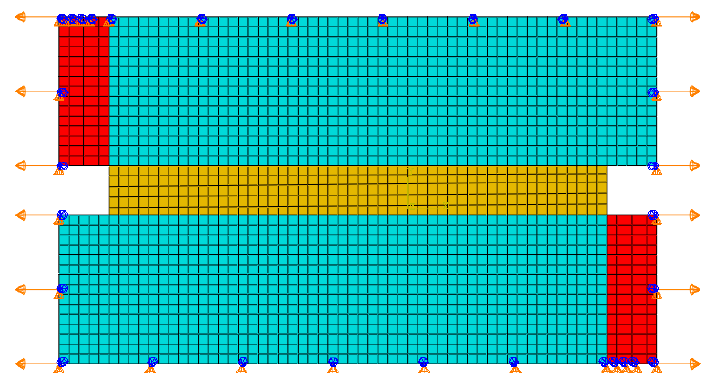
Figure 8. Finite element modelling (FEM) model with mesh properties of the unit cell. Cohesive elements are inserted in the red region. In the FEM model, the periodic boundary conditions were set to the upper and lower edges, and uniform-speed displacement tension load was set to the left and right edges. Table 2. Geometrical properties used for FEM simulation.